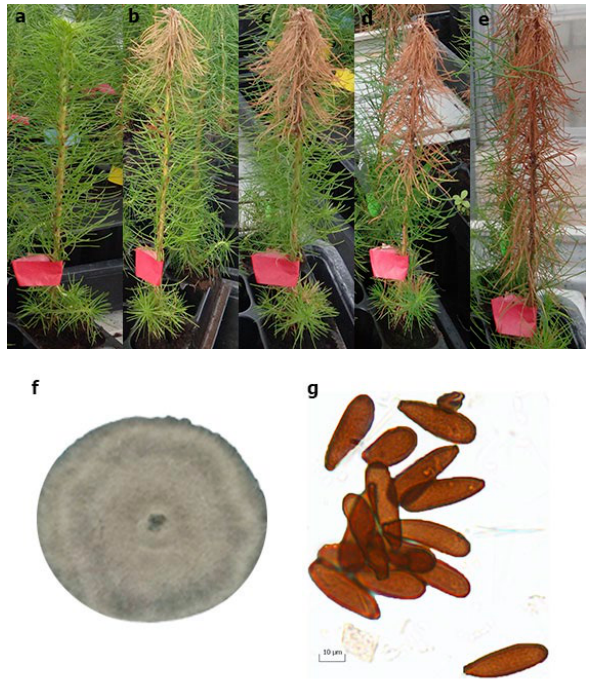
Figure 1. Disease caused by Diplodia scrobiculata on Pinus radiata seedlings. a : Uninoculated control. b: Symptoms produced 16 d after inoculation. c: at 30 d. d: at 55 d. e: at 75 d. f : Mycelium of the pathogen growing on PDA. g : Conidia of Diplodia scrobiculata